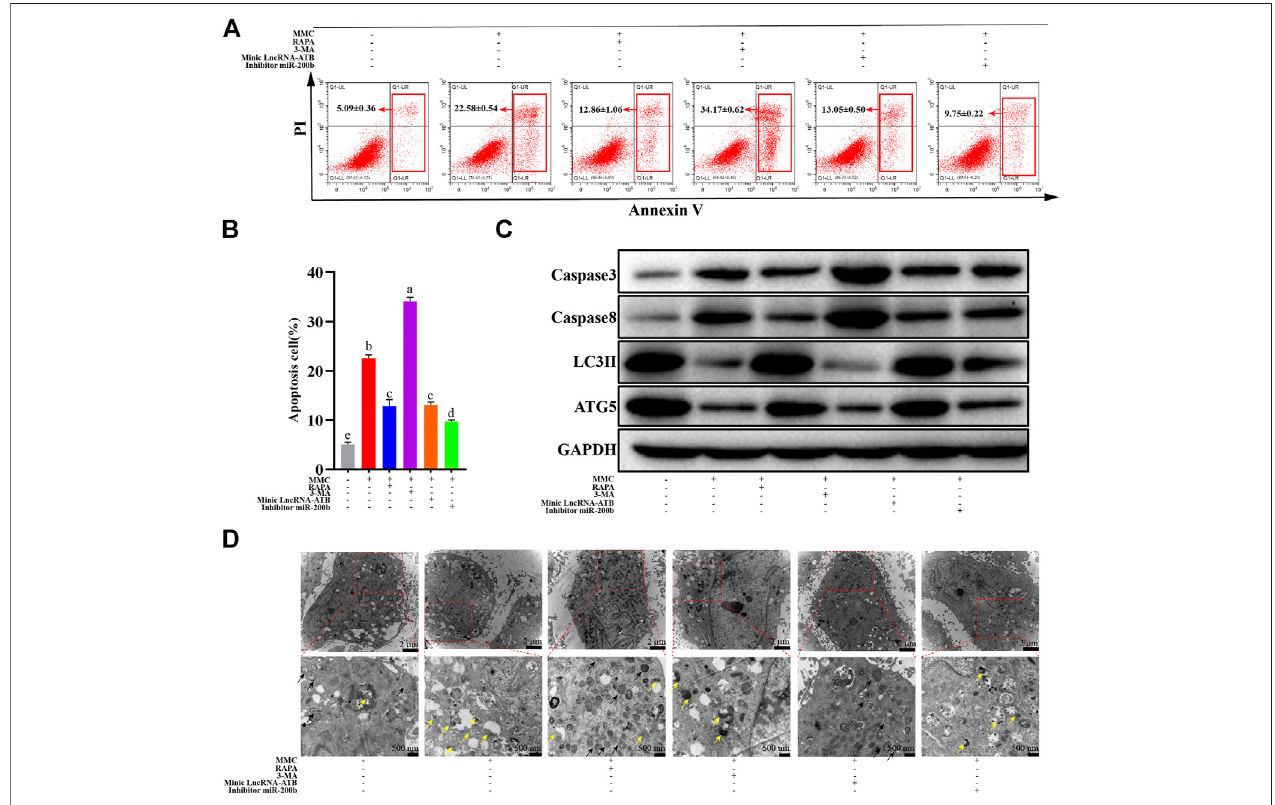
FIGURE4| MMCtreatmentcombinedwithautophagyagonistorantagonist,orlncRNA-ATBmimicormiR-200binhibitorregulatedcellapoptosisandautophagy. (A) Apoptosis was assessed by annexin V-FITC/PI staining followed by fl ow cytometry with HEFS treated with or without MMC for 24 h, MMC + RAPA, MMC+3-MA, MMC+lncRNA-ATBmimicorMMC+miR-200binhibitor. (B) Apoptosispositivecellswerecountedfromthesixgroups. (C) Westernblottingwasusedtodeterminethe expression levelsofCaspase3, Caspase8, LC3IIandATG5aftertreatedwithorwithoutMMCfor24 h,MMC+RAPA,MMC+3-MA,MMC+lncRNA-ATBmimicor MMC + miR-200b inhibitor. (D) Autophagosomes and lysosomes were observed after treatment with MMC or combined with other drugs. Different letters on the bar chart meant signi fi cant